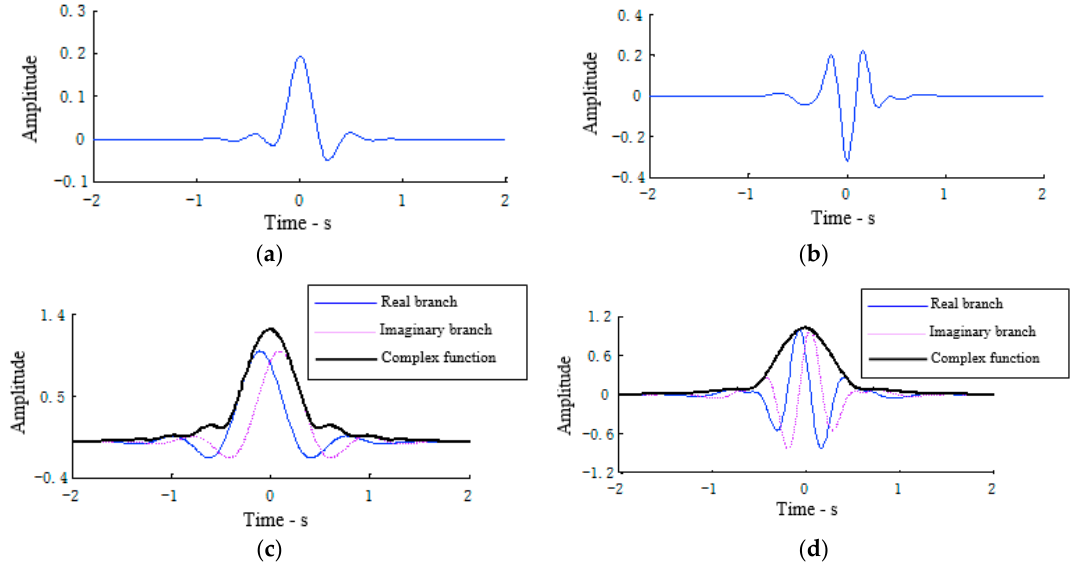
Figure 2. Hybrid wavelet bases of dual tree complex wavelet packet decomposition. ( a ) Scaling function of Symlet10; ( b ) wavelet function of Symlet10; ( c ) complex scaling function of Q-Shift20 and ( d ) complex wavelet function of Q-Shift20.